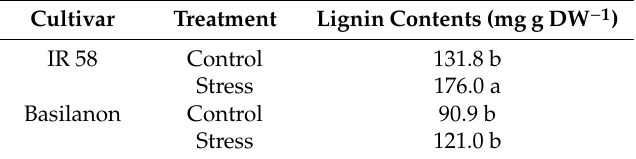
Table 4. E ff ect of osmotic stress on root lignin